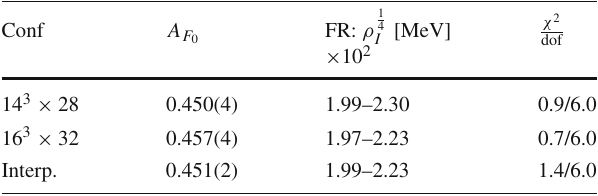
Table 15 Comparisons of the fitting results. The fitting results are figurations of β = 6 . 0000, V = 14 3 × 28 and V = 16 3 × 32 and the interpolated results are used